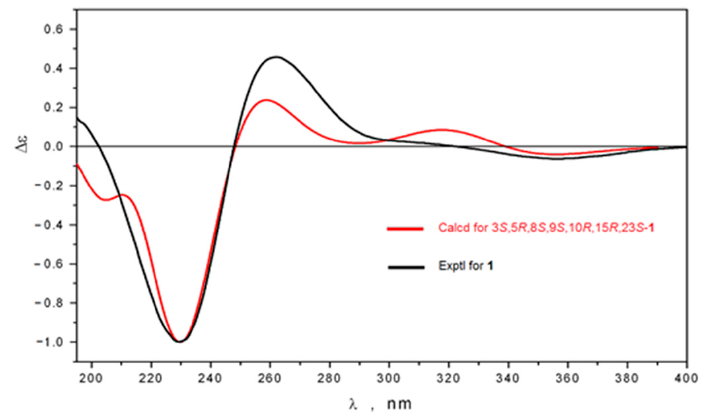
Figure 3. Comparison of experimental and theoretical ECD spectra of stellettin Q ( 1 ). Table 1. 1 H and 13 C NMR data of 1 (700 and 176 MHz) and 2 (500 and 126 MHz) in CDCl 3 .